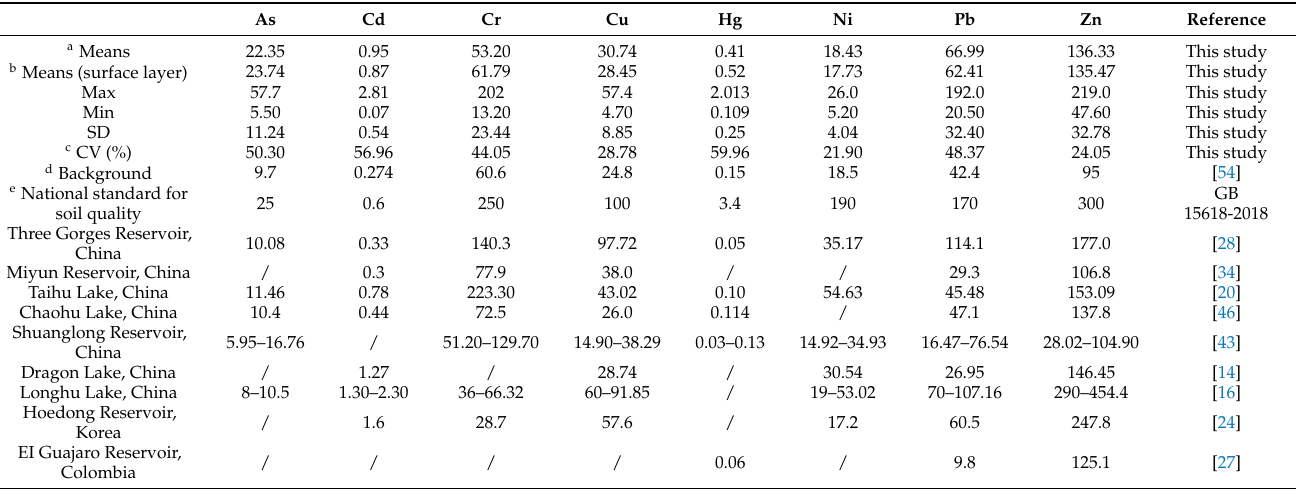
Table 1. Comparison of As, Cd, Cr, Cu, Hg, Ni, Pb, and Zn concentrations determined in this study, the geogenic background, and other reservoirs or drinking water lake sediments (mg/kg dry weight).